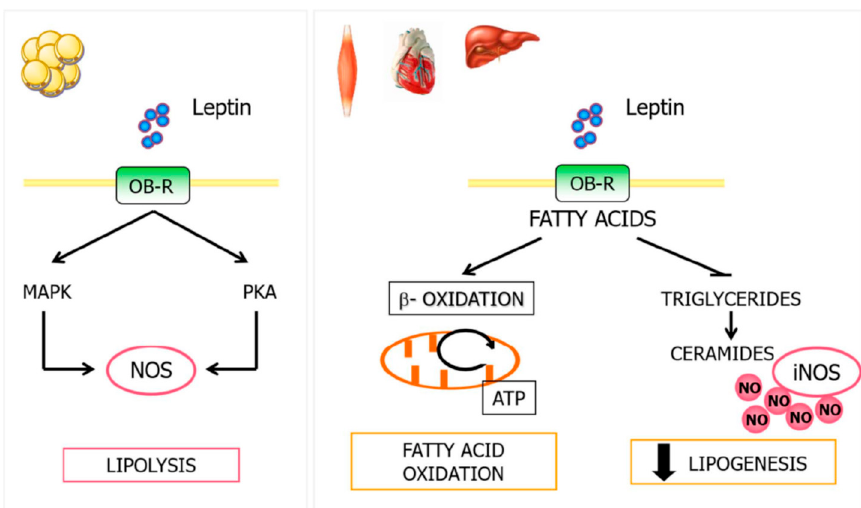
Figure 3. Relationship between leptin and NO in lipid metabolism. Leptin modulates NO production in WAT through PKA and MAP kinase activation, being an important regulator signal of leptin-induced lipolysis. In peripheral tissues, leptin induces fatty acid oxidation, inhibiting lipid accumulation, decreasing lipogenesis, and reducing lipotoxicity associated with non-oxidative fatty acid metabolism. MAPK, mitogen-activated protein kinase; NO, nitric oxide; PKA, protein kinase A; WAT, white adipose tissue.